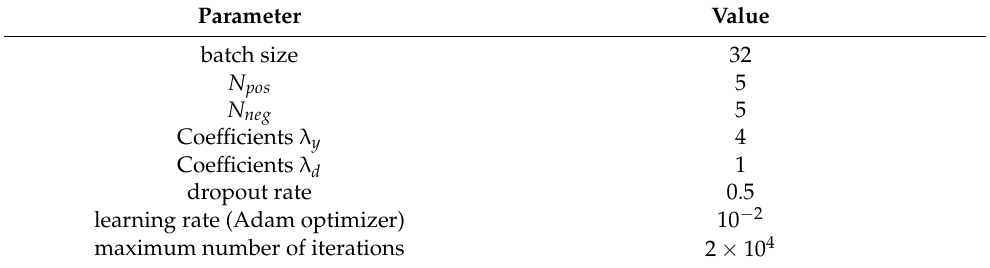
Table 1. Parameters. Parameter Value batch